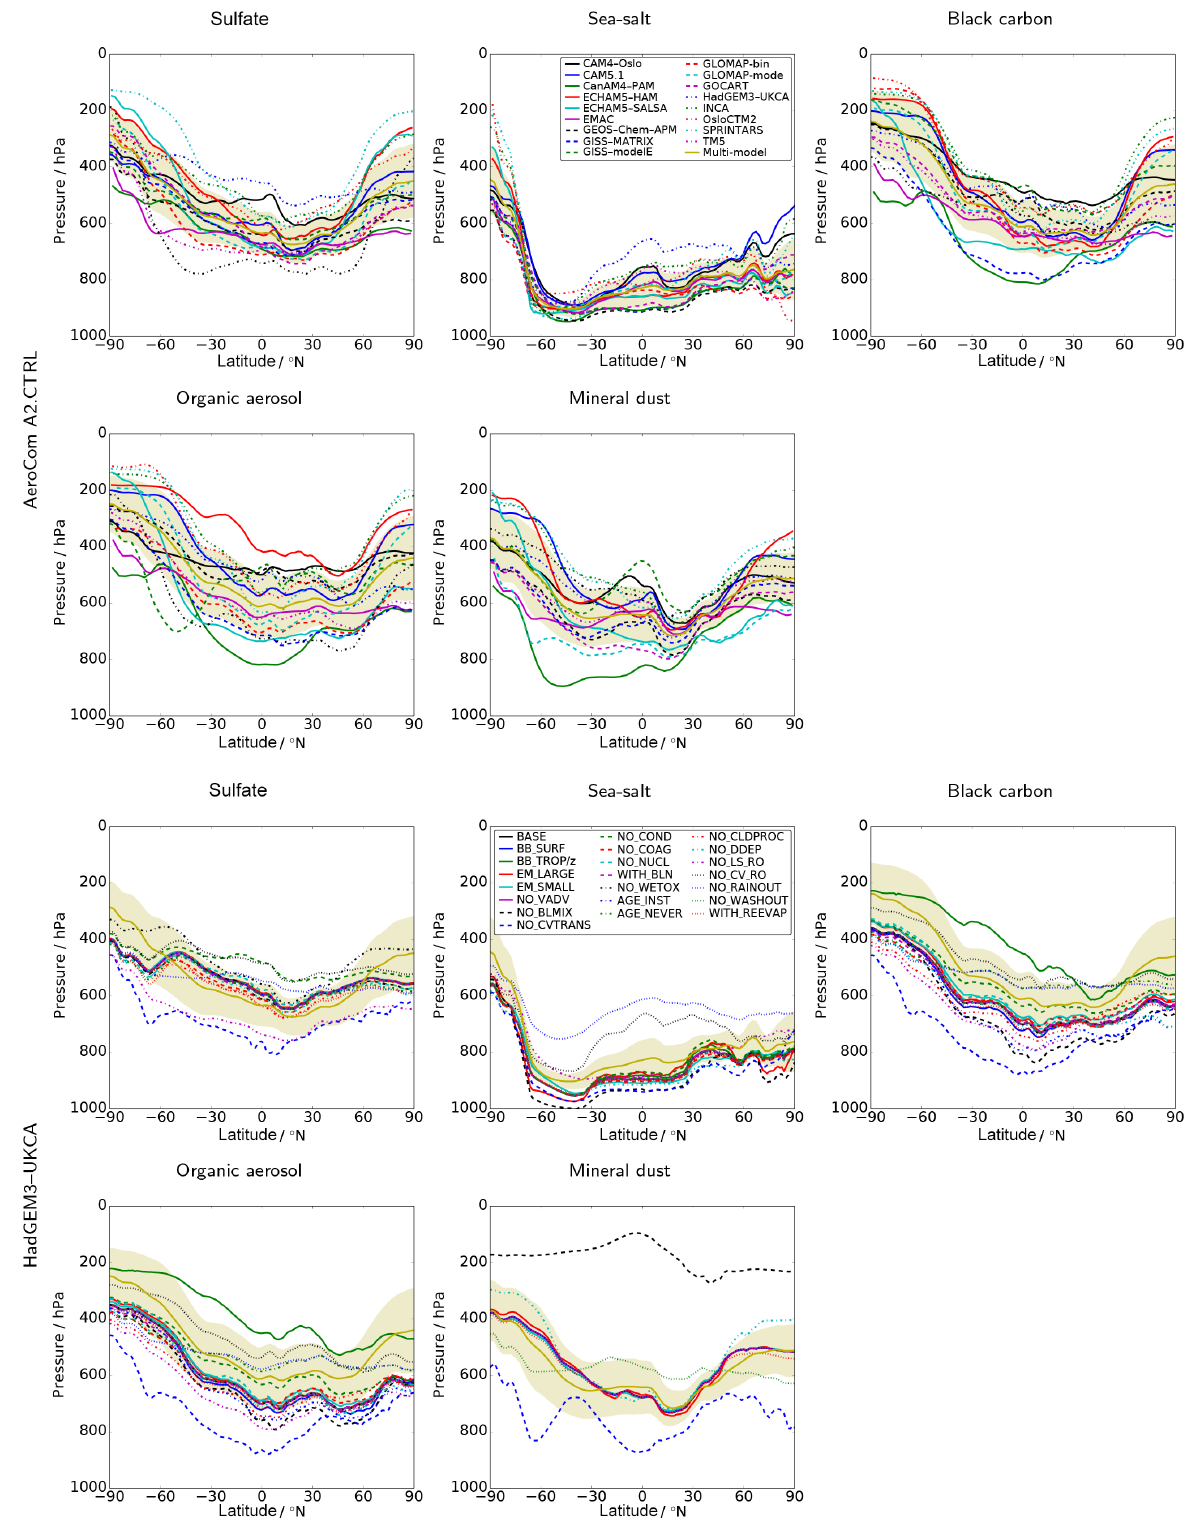
Figure 3. Annual- and zonal-mean mass-weighted mean pressure level (vertical centre of mass in pressure coordinates) of sulfate, sea salt, black carbon, organic aerosol and mineral dust from the AeroCom Phase II models (top) and HadGEM3–UKCA sensitivity-test simulations (bottom). The multi-model mean and standard deviation of the former are indicated by the yellow line and